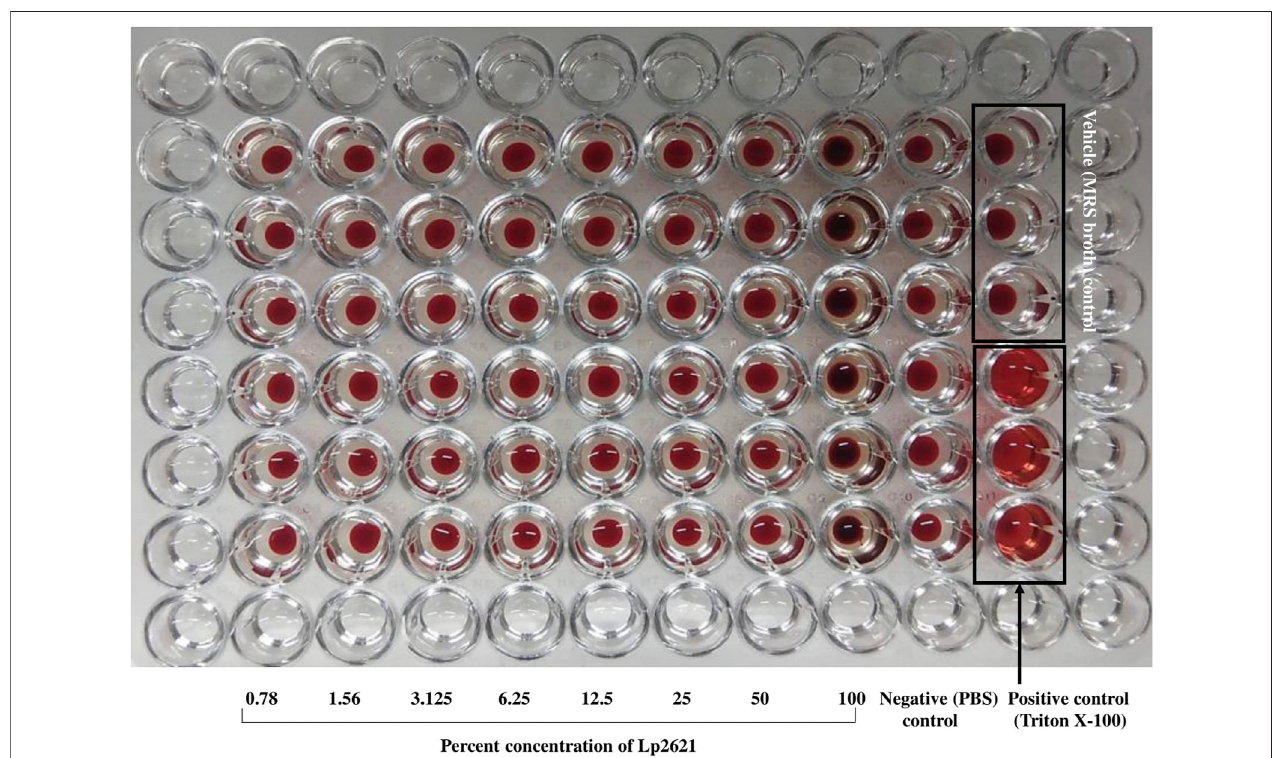
FIGURE 2 | Hemolytic property of Lp2621. The image is a representative of two independent experiments performed in triplicates.